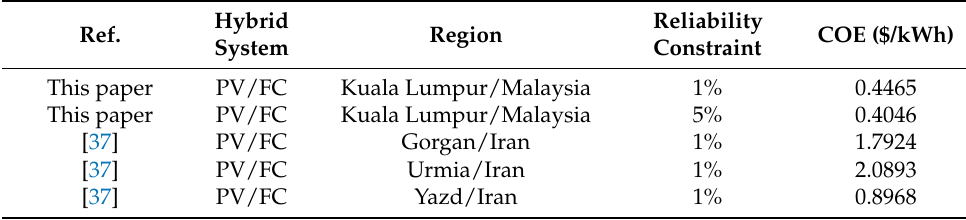
Table 14. Results of